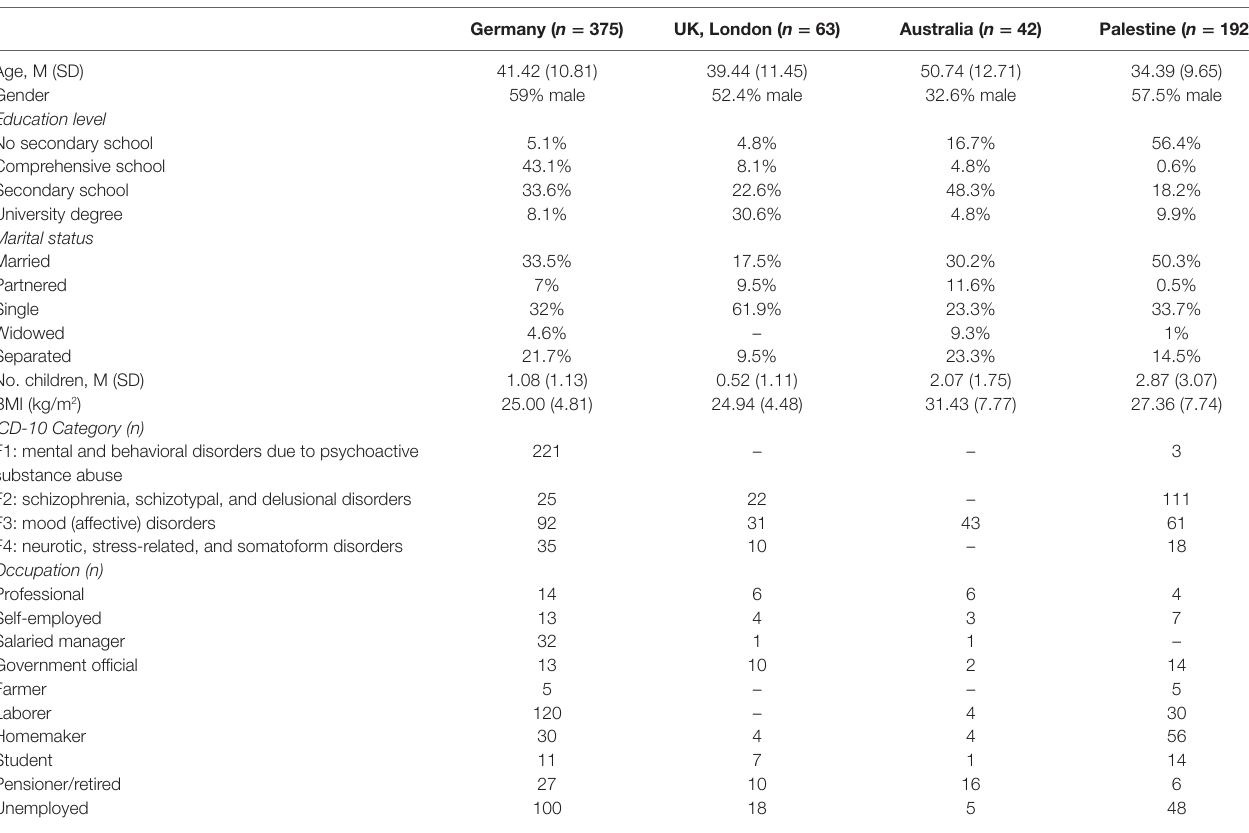
TaBle 1 | Demographic data for sample broken down by country.